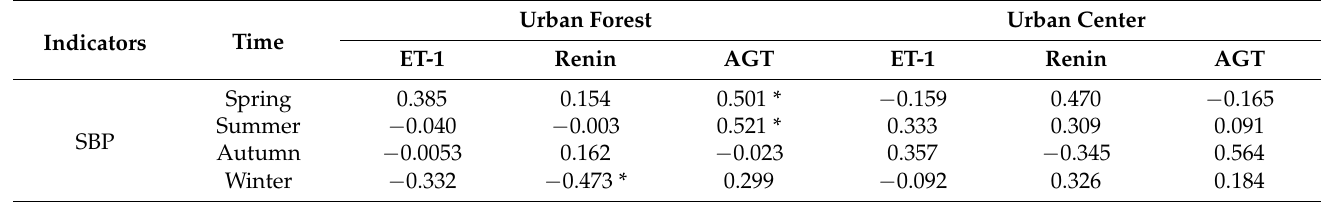
Table 4. The association between changes in biological parameters and blood pressure after forest bathing in different